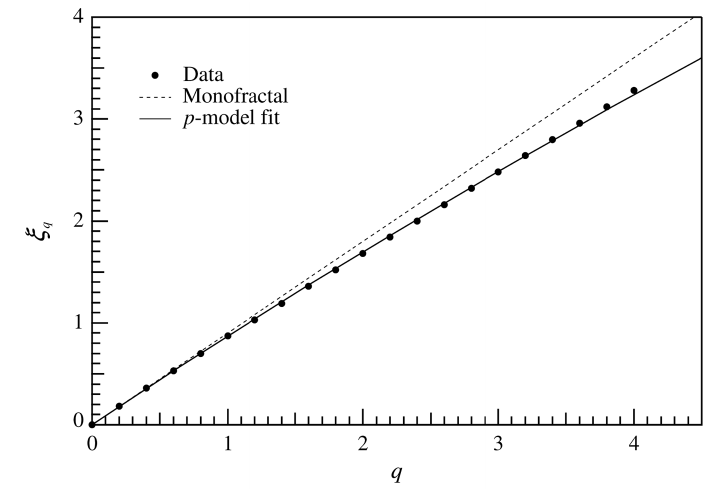
Fig. 4. The structure function scaling exponents ξ q versus the moment order q . The solid black line refers to a nonlinear best fit using the p -model. The resulting fragmentation parameter is approximately p ≈ 0.6. The dashed line refers to a homogeneous fractal